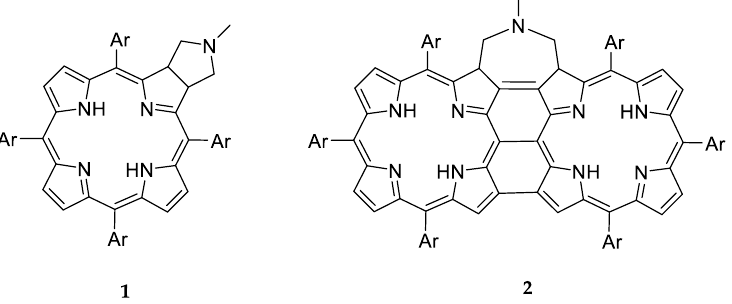
Figure 1. Cycloadducts 1 and 2 reported in the literature for the reaction of meso -tetraarylporphyrins and meso – meso , β - β,β′ - β′ triply linked diporphyrins, respectively, with azomethine ylides.